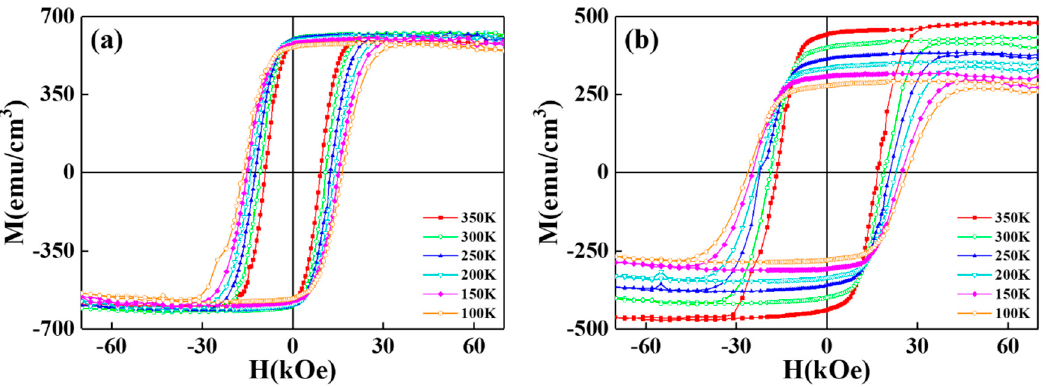
Figure 3. Easy-(out-of-plane) axis magnetization loops of ( a ) reference sample and ( b ) FePtCAg/MgTiOBN films measured from 100 K to 350 K.